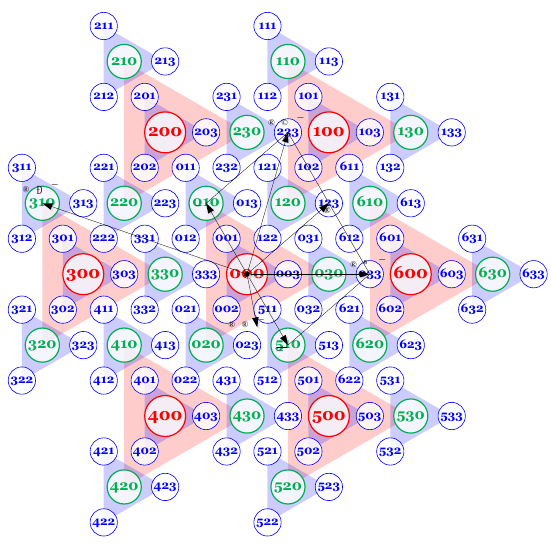
Figure 2. Representation of codes in the 3 rd level and examples of code